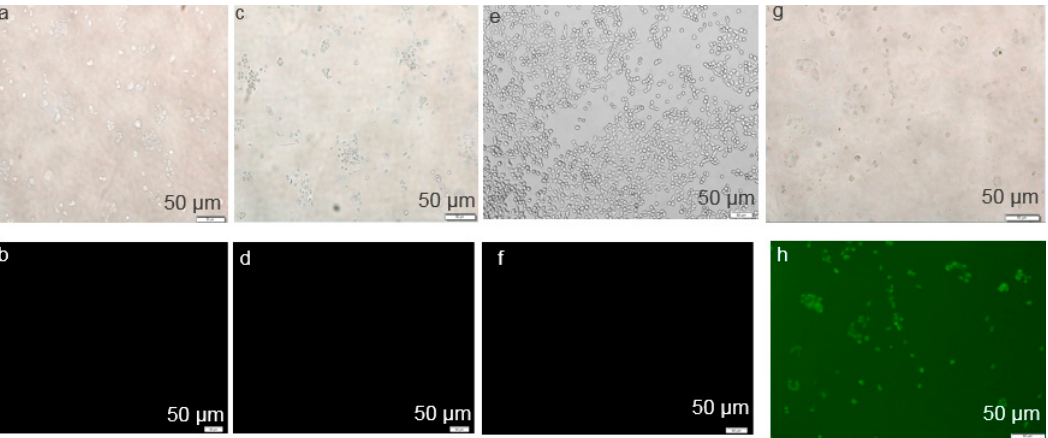
Figure 6. Cellular uptake of NP-bound fluorescent negative siRNA. MCF-7 cells were treated with ( a , b ) media (untreated), ( c , d ) NPs, ( e , f ) free siRNA, and ( g , h ) NPs-siRNA formed with 15 mM of CaCl 2 and 10 nM AF488 negative control siRNA. All images were captured at 10× resolution.